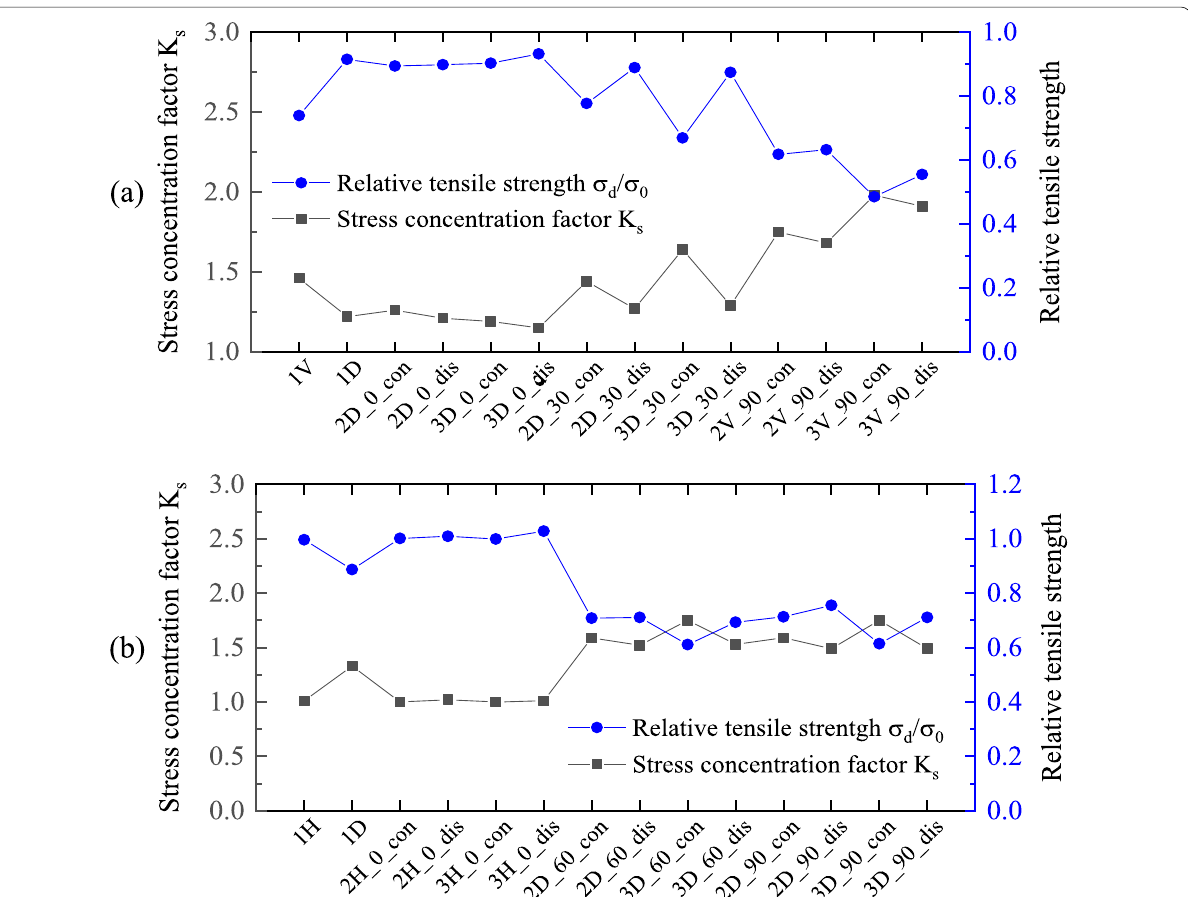
Fig. 7 Stress concentration factors vs. relative tensile strengths for different defective SCNTs. a Zigzag SCNTs; b Armchair